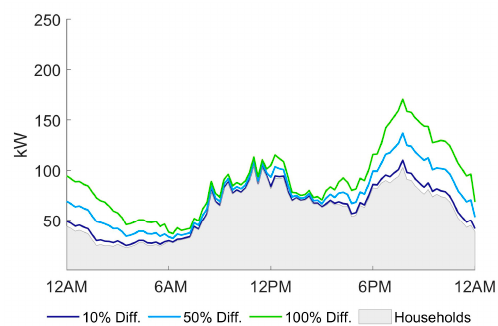
Figure 7. Household load and charging profile applying a low charging capacity (LCC).